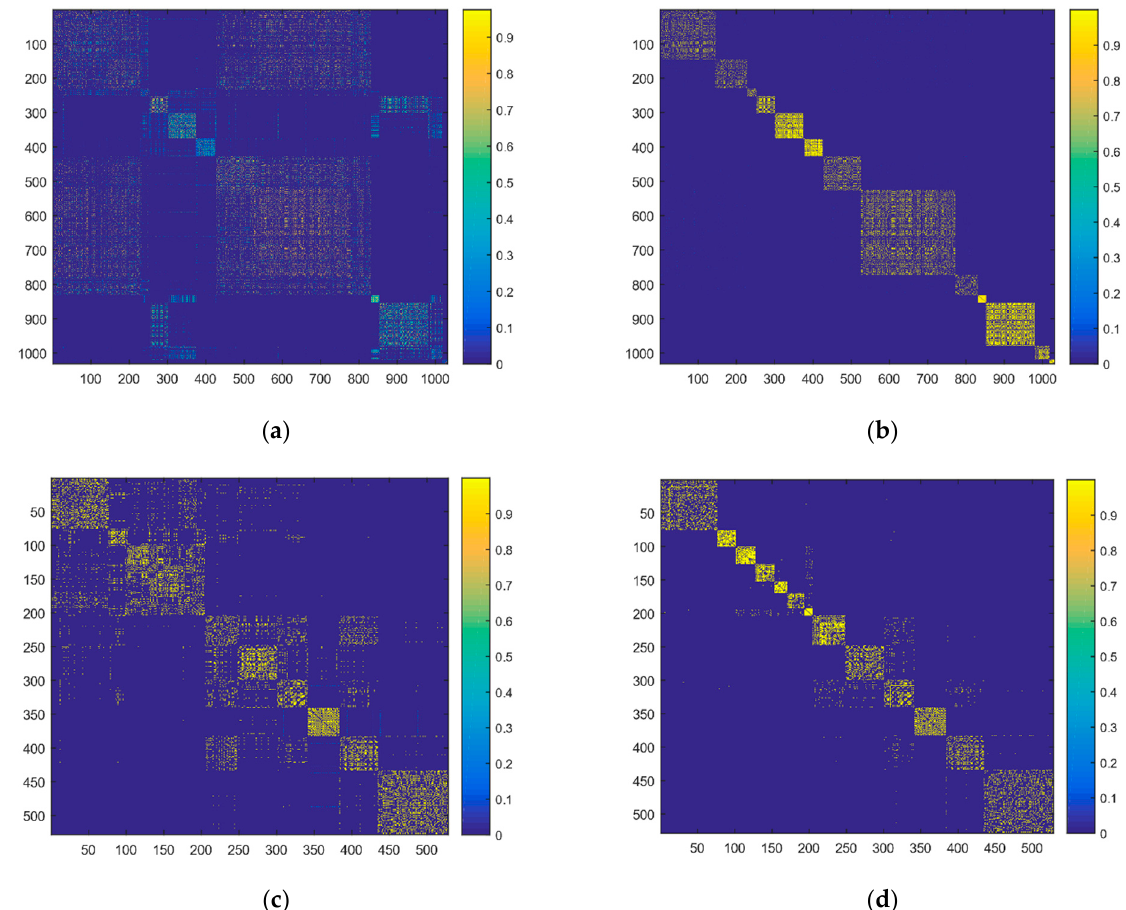
Figure 4. Weight matrices obtained with HSI datasets: ( a ) LPP for Indian Pines; ( b ) Proposed + LPP for Indian Pines; ( c ) OLPP for KSC; ( d ) Proposed + OLPP for KSC. (LPP: Locality Preserving Projection, OLPP: Orthogonal Locality Preserving Projection).